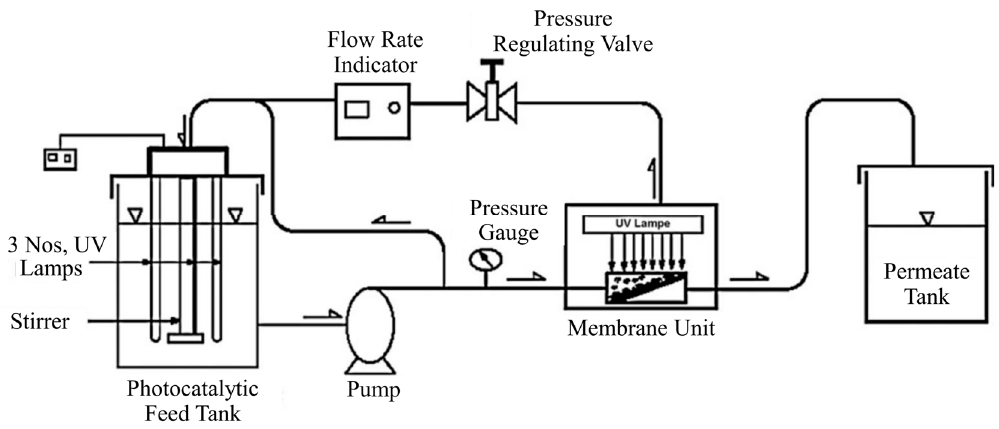
Figure 8. Schematic diagram of a split ‐ type PMR with suspended photocatalyst. The UV lamps were placed in the feed tank as well as above the membrane unit. Adapted with permission from [68], Copyright Elsevier, 2008.